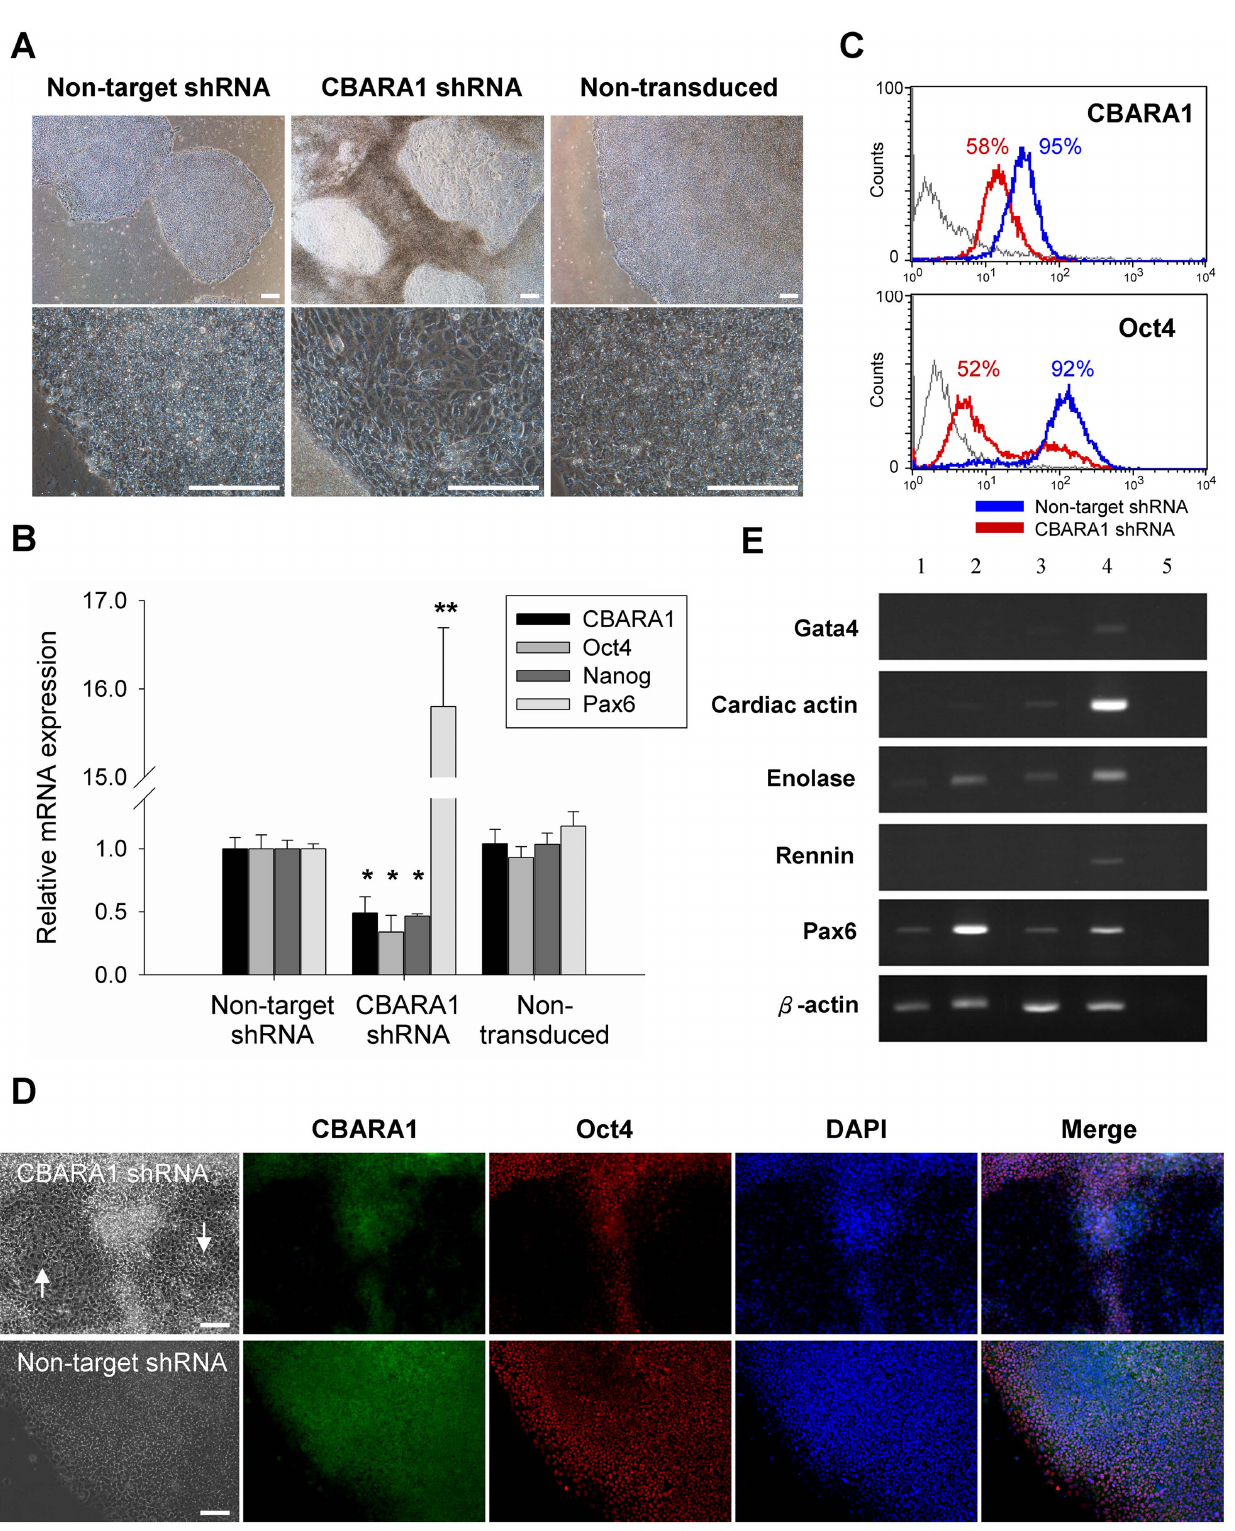
Figure 3. Effect of CBARA1 on hESC stemness. (A) Representative phase-contrast images show CBARA1 shRNA vector-transduced, non-target shRNA vector-transduced, and non-transduced hES3 cells. (B–C) Quantitative PCR and flow cytometry show reduced CBARA1 and Oct4 mRNA and protein expression in CBARA1 shRNA vector-transduced hESCs compared to non-target shRNA vector-transduced and non-transduced controls. Gene expression was normalized to that of GAPDH and is presented as fold-change compared to the non-target shRNA control. Bars represent the means 6 standard deviations of three independent experiments. *Difference compared to non-target shRNA control ( P , 0.05). **Difference compared to non-target shRNA control ( P , 0.01) (D) Representative images show CBARA1 and Oct4 immunostaining in non-target shRNA vector-transduced,